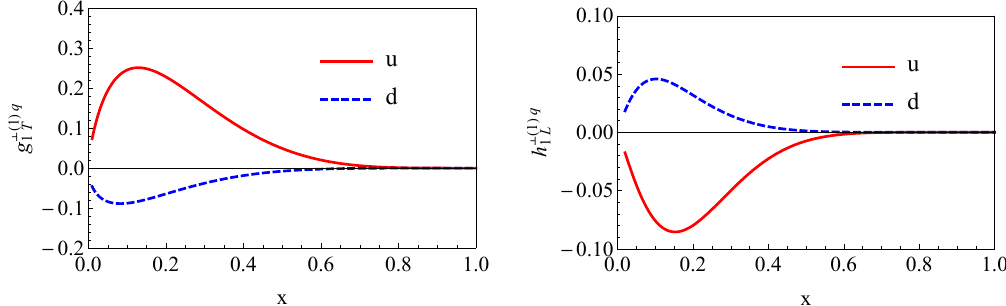
Figure 10. g ? (1) q ( x ) (left panel) and h ? (1) q ( x ) distributions (right panel) for up and down (cid:13)avor 1 T 1 L as predicted by the WW-type approximations in eqs. (3.6a), (3.6b).